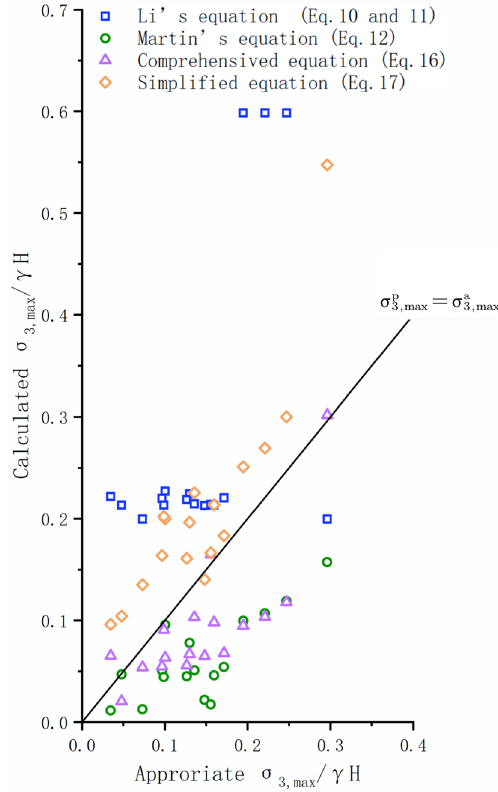
σ ′ 3,max γ H values and predicted values from different equations (